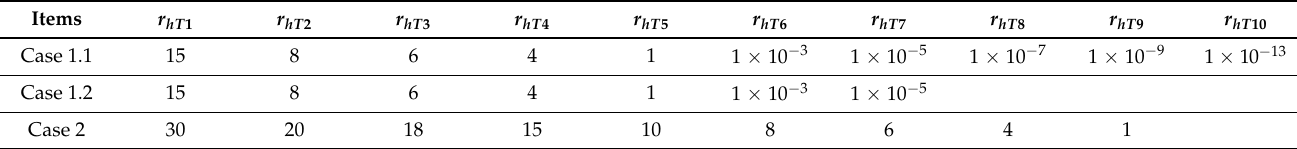
Table 2. Parameters of r hT